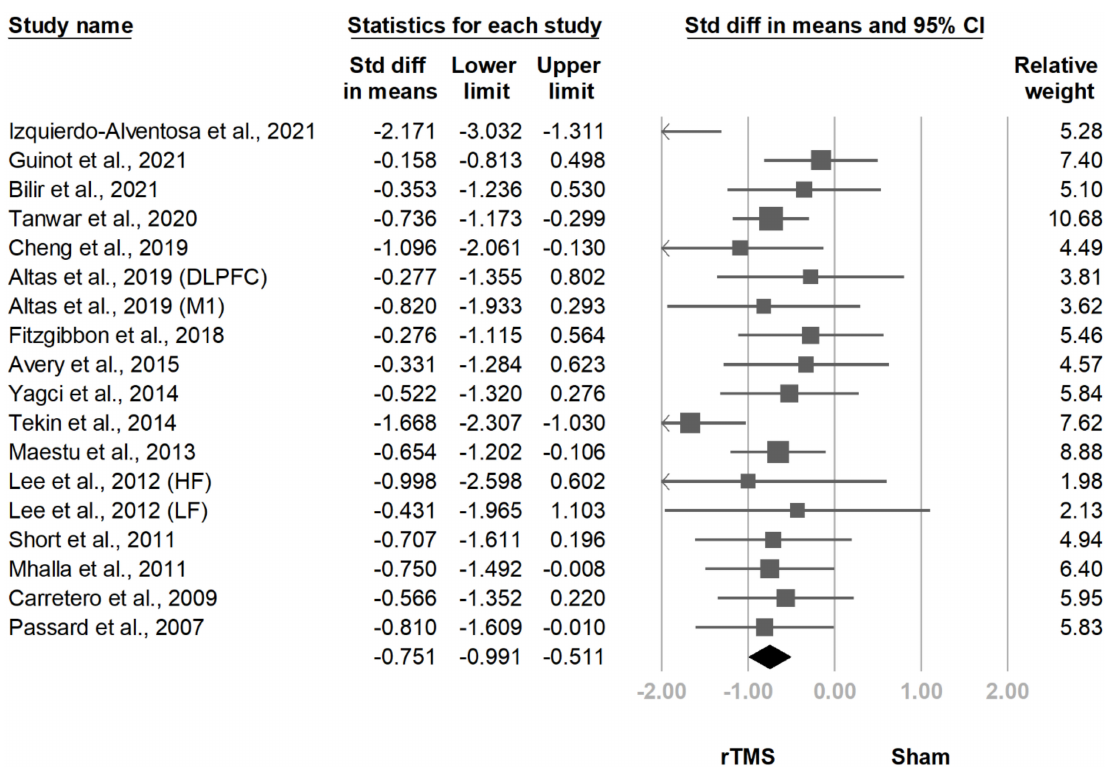
Figure 6. Forest plot of standardized mean differences in intensity of pain after treatment. Squares indicate effect sizes of individual studies, lines indicate 95% CI, and diamond indicates the summarized effect